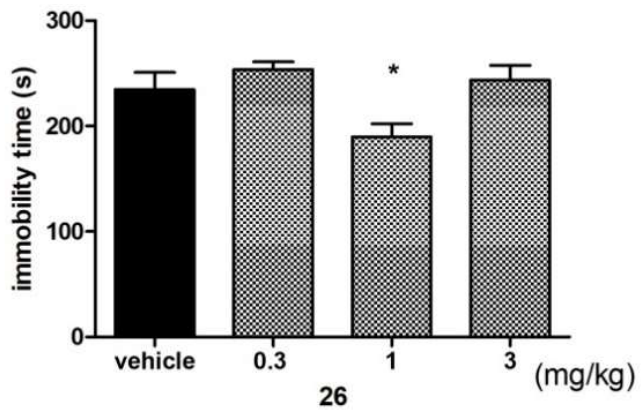
Figure 3. Influence of compound 26 on the immobility time of rats in the forced swim test. Compound 26 was administered i.p. 60 min before the test. The animals were observed for 5 min.